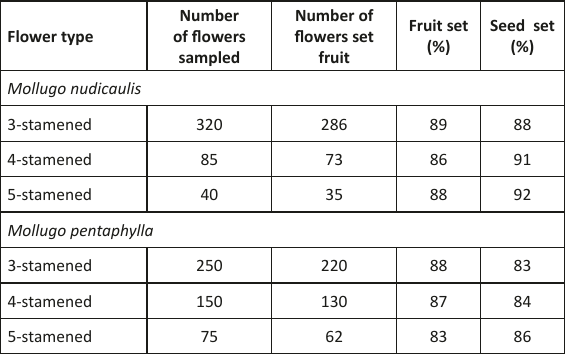
Table 4. Natural fruit and seed set rate in Mollugo nudicaulis and M. pentaphylla Flower